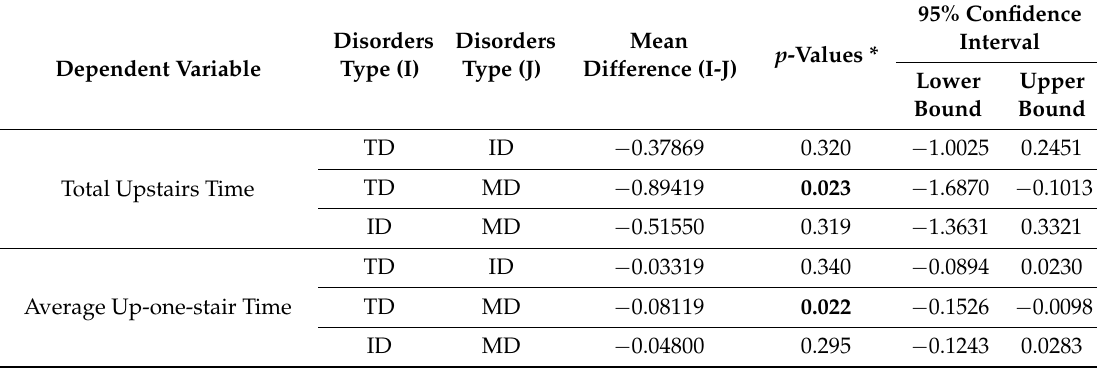
Table 4. Post hoc tests of upstairs walking for three